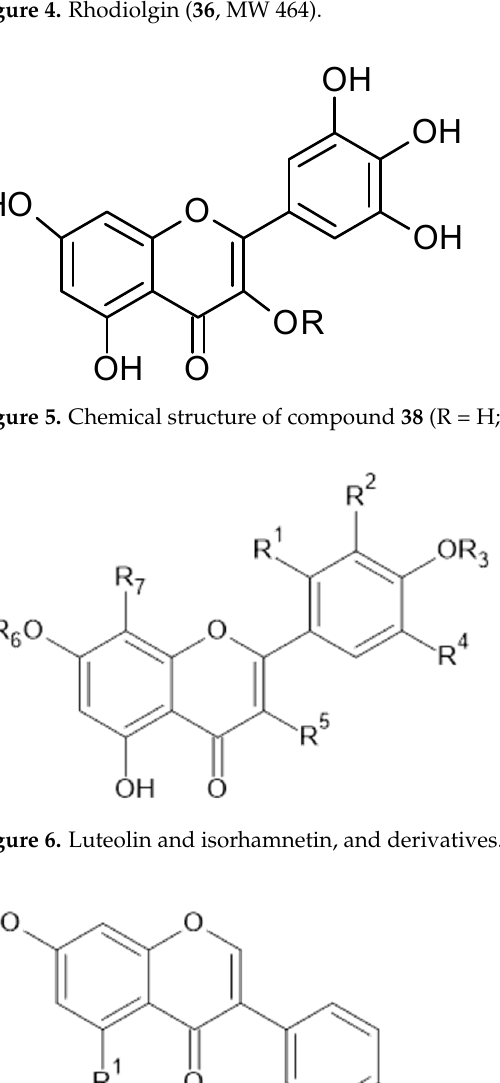
Figure 4. Rhodiolgin ( 36 , MW 464).